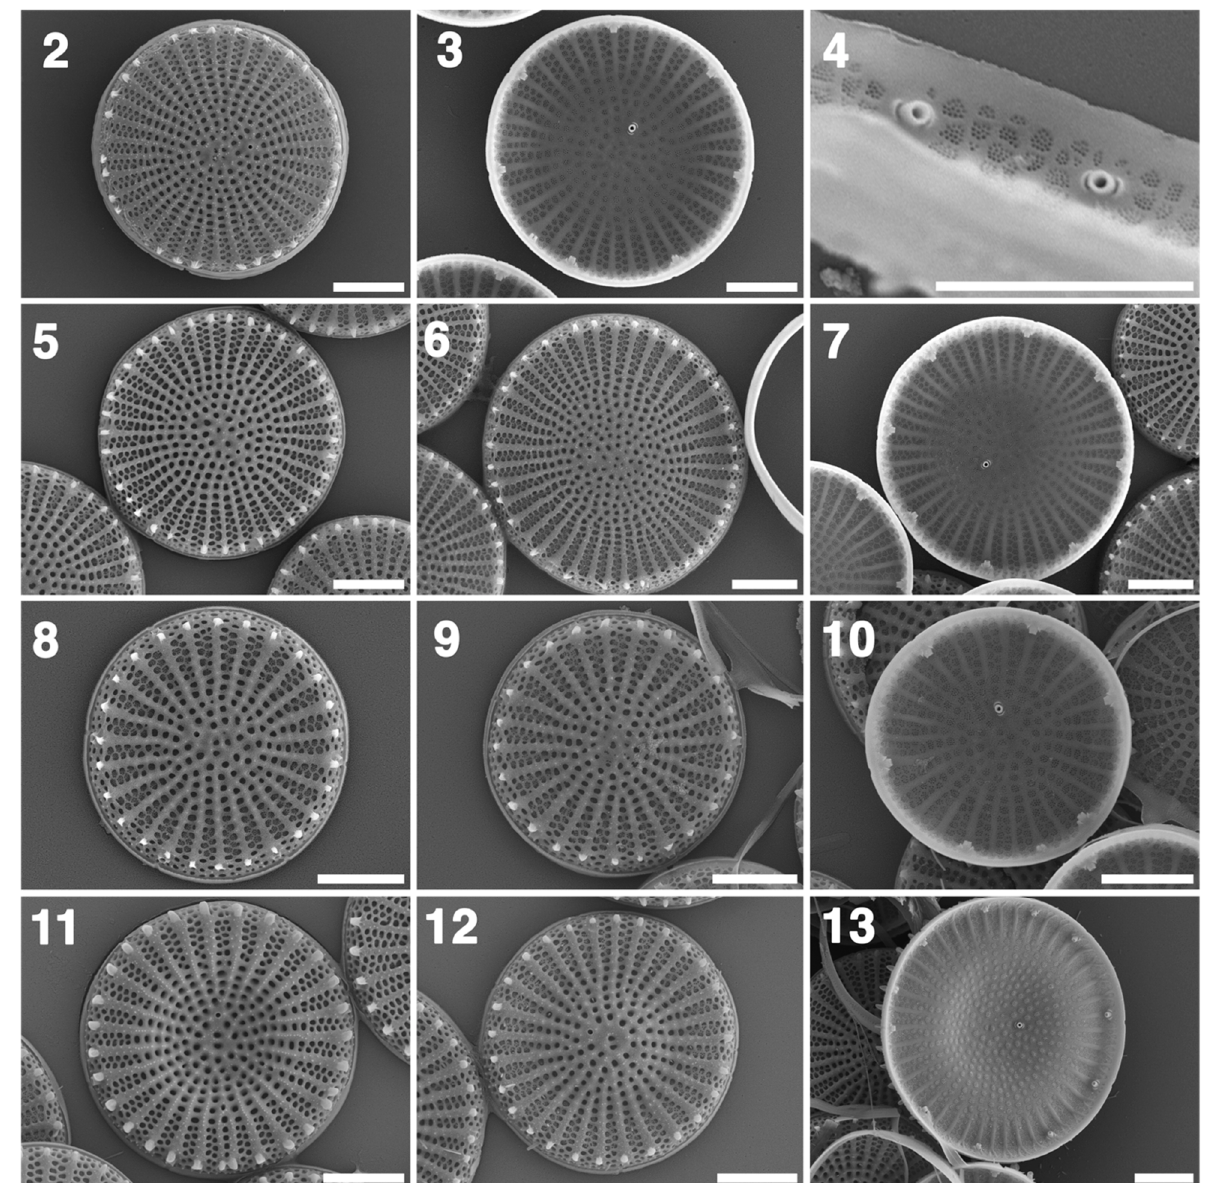
Figure 2. ( 2 – 13 ) SEM photographs of the internal and external ultrastructure of Cyclostephanos makarovae comb. nov. ( 2 – 4 ) strain MIC7; ( 5 – 8 ) strain QC3; ( 8 – 10 ) strain SN29; ( 11 – 13 ) strain US5. Scale bars = 2 µm.